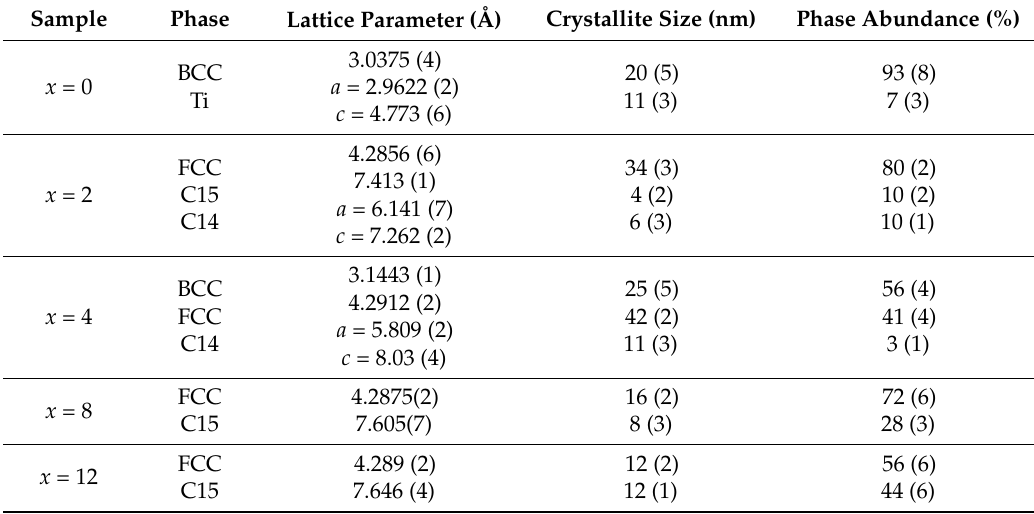
Figure 5. X-ray diffraction patterns of: Ti 1 V 0.9 Cr 1.1 + x wt % Zr alloys in the hydrogenated state for x = 0, 2, 4, 8, and 12. Table 7. Crystal parameters and abundance of each phase in hydrogenated: Ti 1 V 0.9 Cr 1.1 + x wt % Zr alloys for x = 0, 2, 4, 8, and 12. Error on the last significant digit is indicated in parentheses.